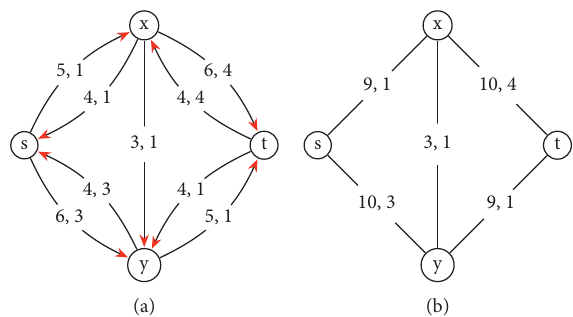
Figure 1: Network with capacities and transit times, respectively. (a) Evacuation network. (b) Auxiliary network.